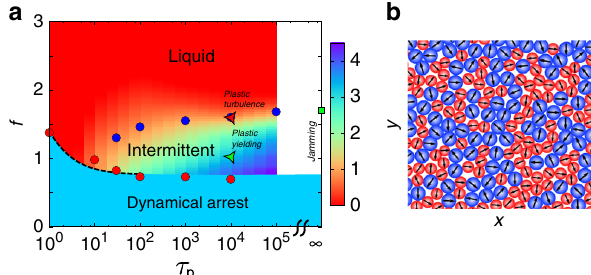
Fig. 1 Dynamical phase diagram in the f − τ p plane at fi xed density. a At low τ p (0 < τ p < 10), there is a direct transition at f = f c ( τ p ) (red dots), from the liquid to a dynamically arrested phase, as measured from the the divergence of τ α , the slow relaxation of the density fl uctuations (Fig. 2c). This transition to the dynamically arrested state continues into larger values of τ p (red dots). The dashed line is a fi t to the active RFOT theory 16 , with an effective temperature Af 2 τ p /(1 + B τ p ), where A and B are fi t parameters. At larger values of τ p > 10, a new intermittent phase intervenes between the liquid and the dynamically arrested phases. The liquid- intermittent phase boundary, f = f * ( τ p ), is obtained from the dynamical order parameter, the excess kurtosis κ ex (Fig. 2e) and the peak height h p (Fig. 2f), shown with blue circles. This transition is very sharp and continuous at large values of τ p , and gets progressively broader and less de fi ned at lower values of τ p (colour bar represents the value of κ ex (0 + ) in log 10 for different f and τ p ). This intermittent phase is characterised by bursts of plastic yielding and turbulence close to the transition to the liquid phase. At τ p = ∞ , the assembly shows a sudden transition from a liquid to a jammed con fi guration at a force threshold, f = f * ( ∞ ), where the particles suddenly get into a force-balanced con fi guration (Fig. 5d). b Schematic of a dense assembly of the bidisperse A (red) – B (blue) soft Lennard – Jones particles, with arrows marking the instantaneous direction of self-